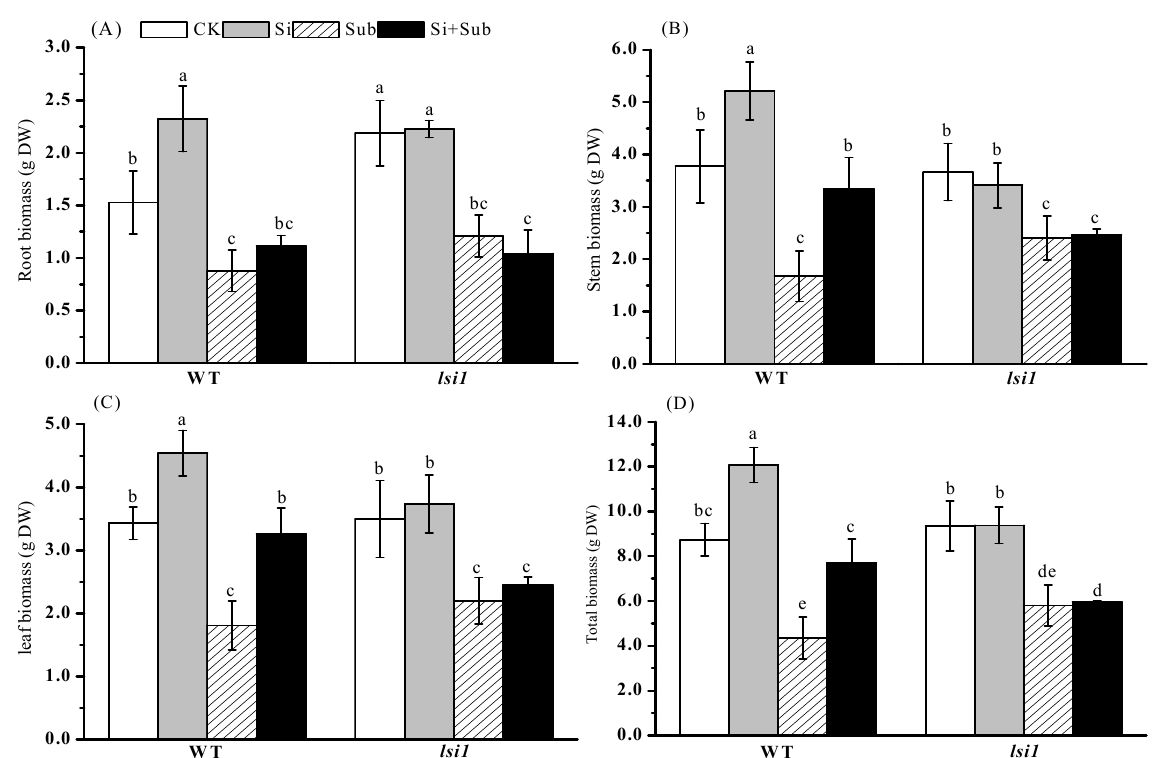
Figure 1. Effects of Si application on root ( A ), stem ( B ), leaf ( C ), and total biomass ( D ) of rice under submergence stress. Values are expressed as mean ± SE from three replicates (n = 3). The different letters above the bars indicate significant differences among all treatments ( p < 0.05). WT, wild type; DW, dry weight.